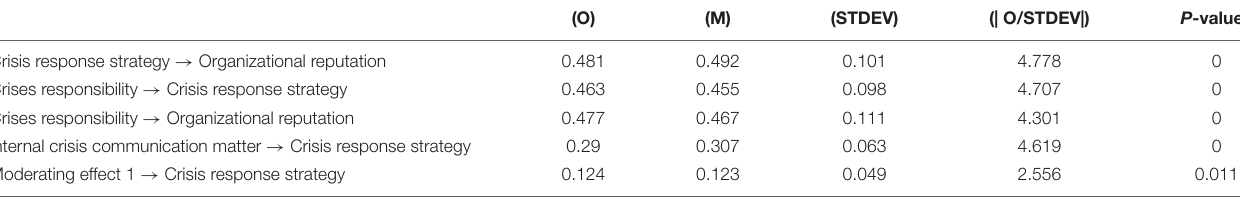
TABLE 4 | Direct effect results.